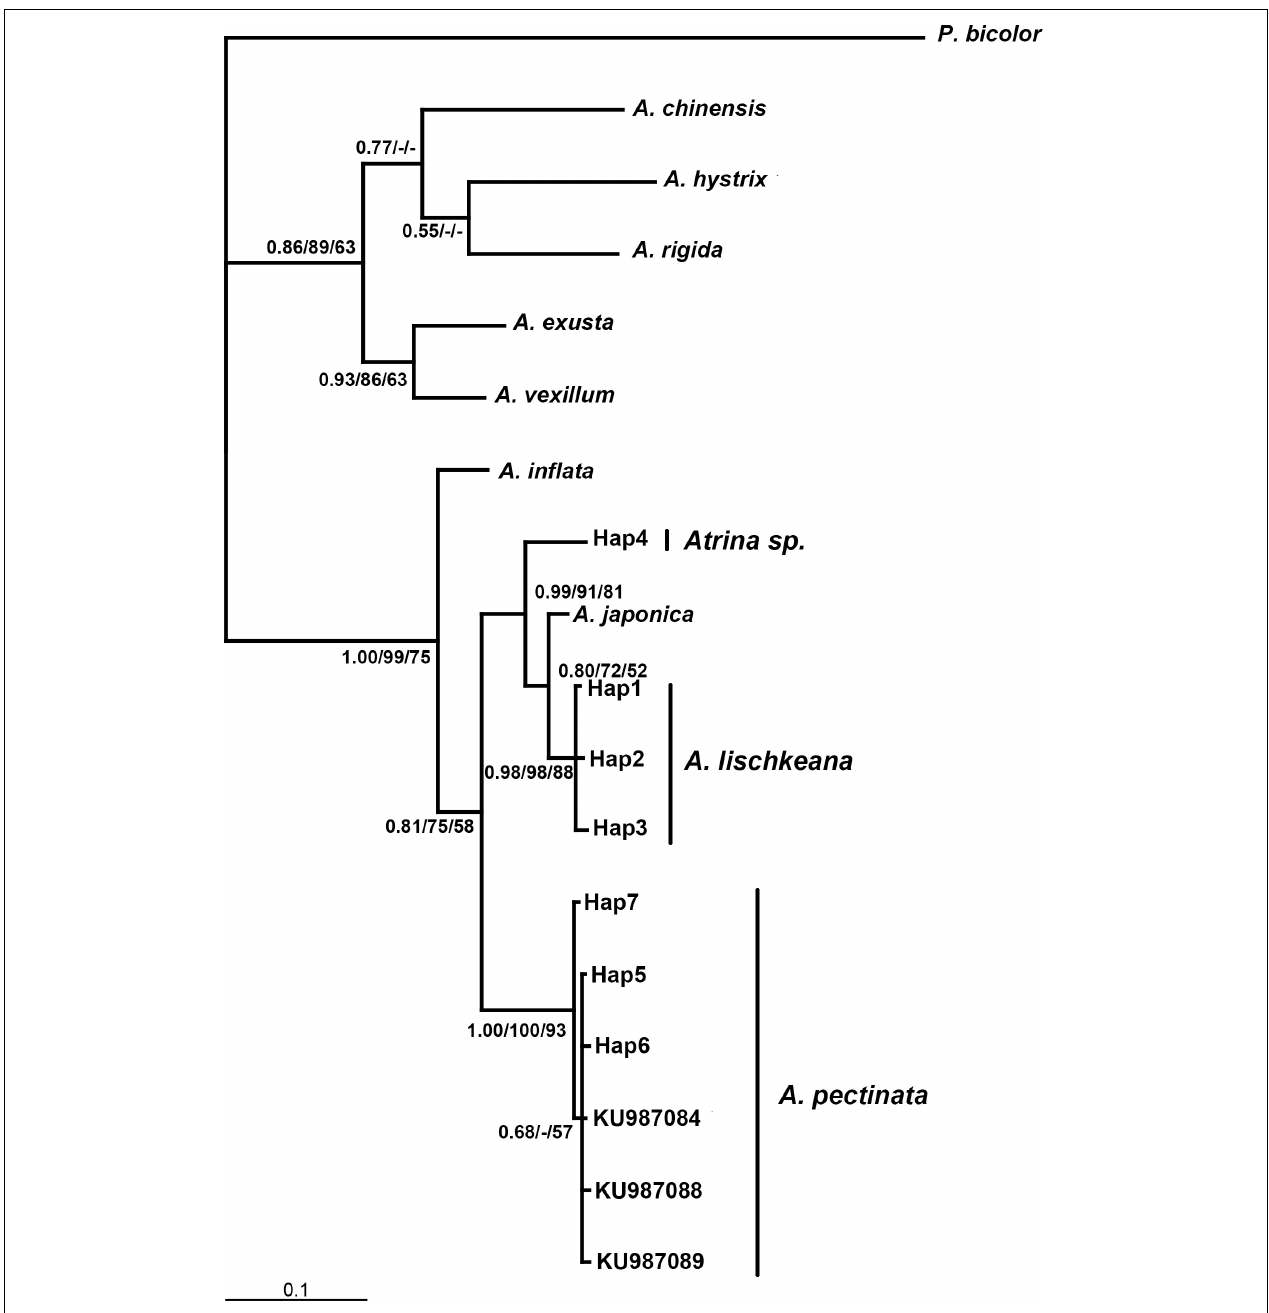
FIGURE 5 | Bayesian tree of mt 16S rRNA showing the phylogenetic placement of the four species in the A. pectinata species complex. The numbers at the nodes represent the Bayesian inference posterior probabilities, neighbor-joining, and maximum likelihood probability support.